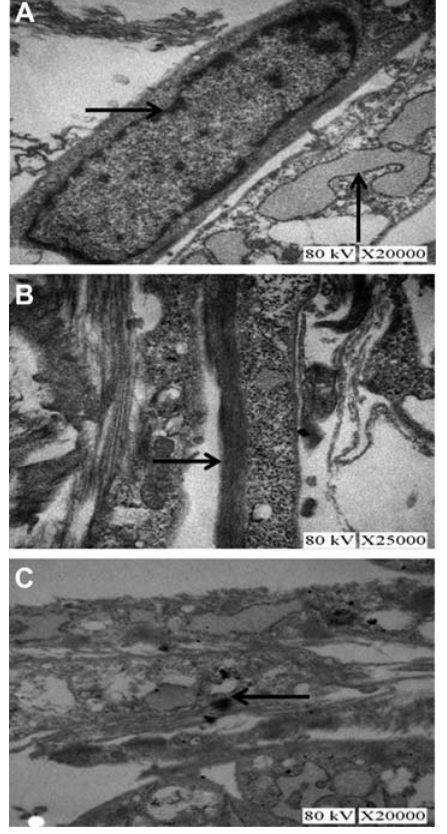
Figure 3. Transforming growth factor beta induced rat bone marrow mesenchymal stem cells evaluated by a transmission electron microscope. A , Abundant organelles, such as rough endoplasmic reticulum and mitochondria (vertical arrow), can be seen in the cytoplasm, with an oval nucleus (horizontal arrow) located in the center of the cells, (cid:1) 20,000. B , Myo fi laments (horizontal arrow) were found in parallel in the cytoplasm, with light and dark transverse striation, (cid:1) 25,000. C , Gap junction (horizontal arrow) between cells, (cid:1) 20,000.